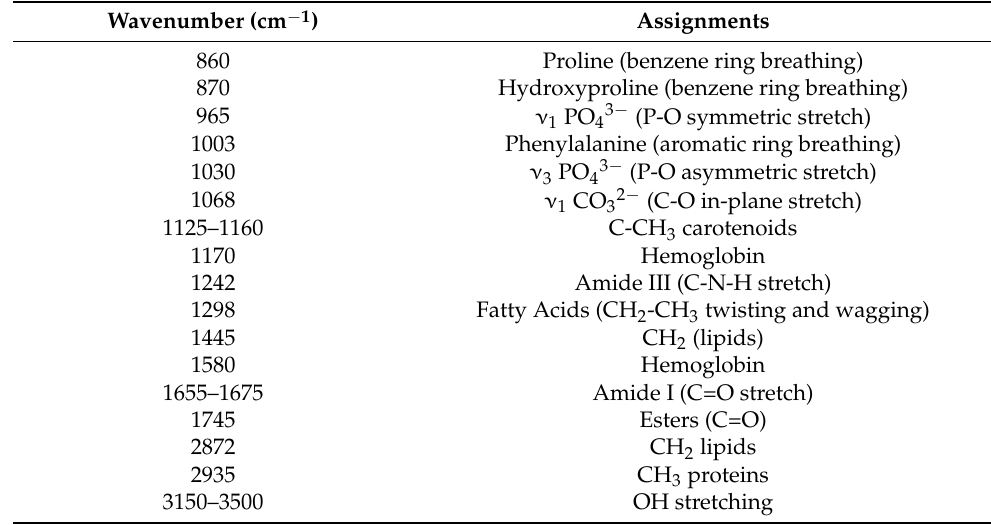
Table 1. Typical Raman vibrations detected on bone tissue